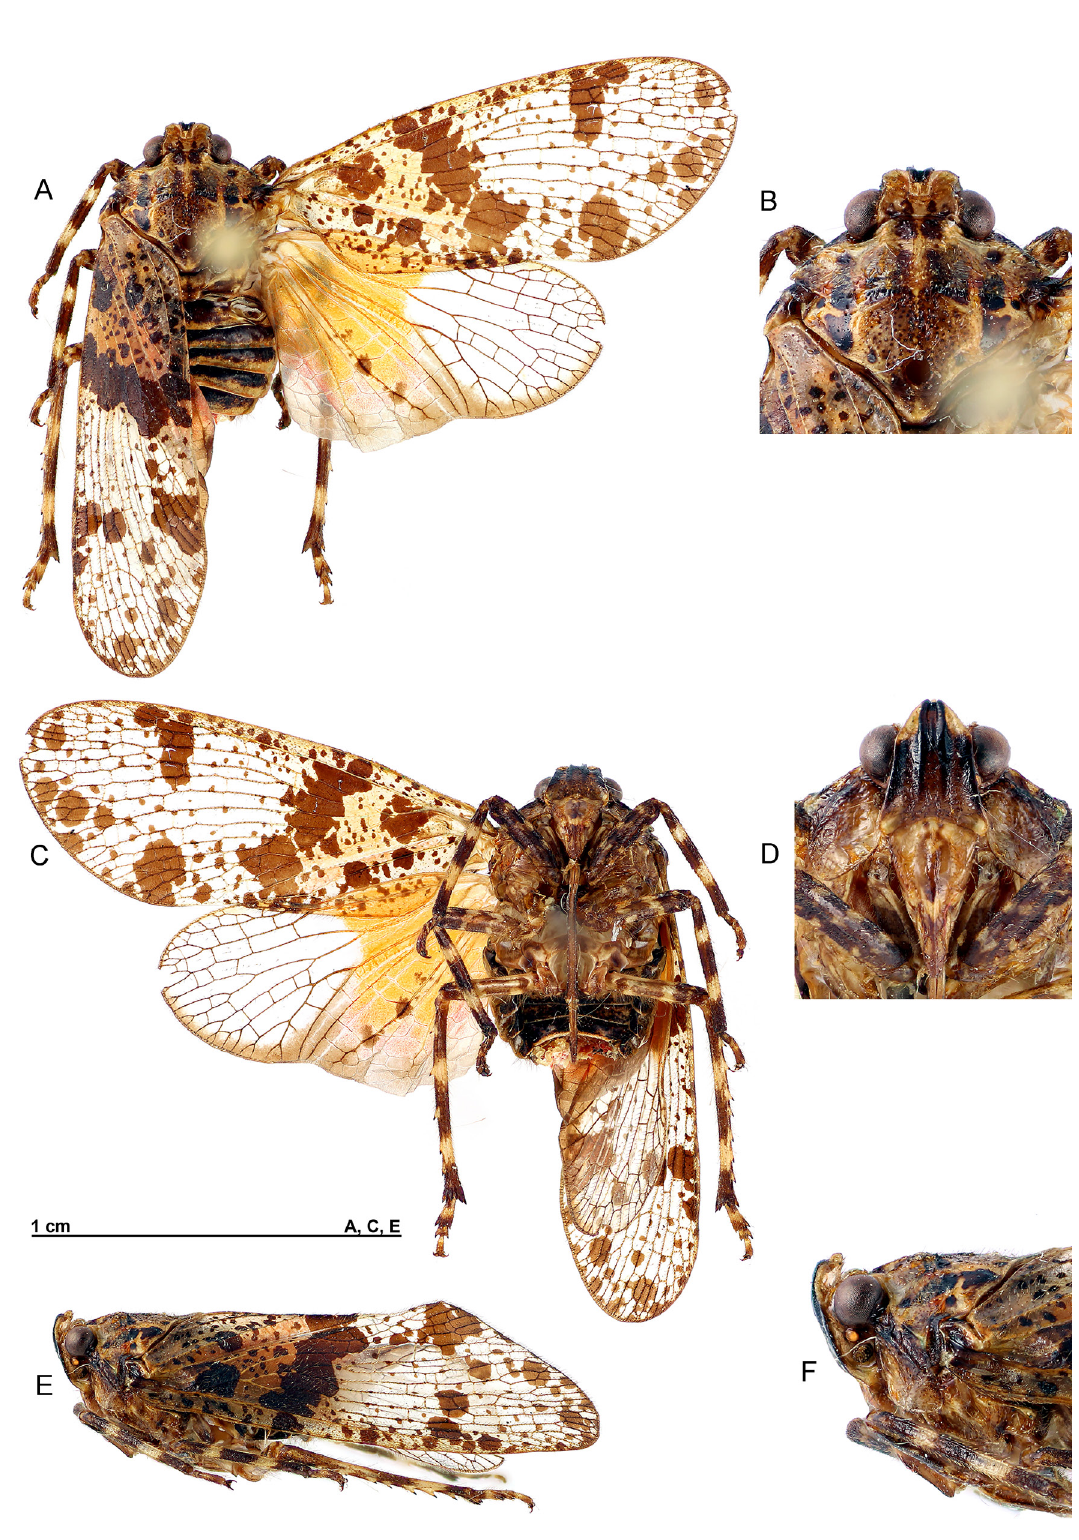
Fig. 11. Limois emelianovi Oshanin, 1908, Vladivostok, Anufriev leg., RBINS, adult male. A . Dorsal view. B . Head and thorax, dorsal view. C . Adult, ventral view. D . Face. E . Left lateral view. F . Head and thorax, left lateral view (showing reflexed protuberance of the vertex). Photographs by J.